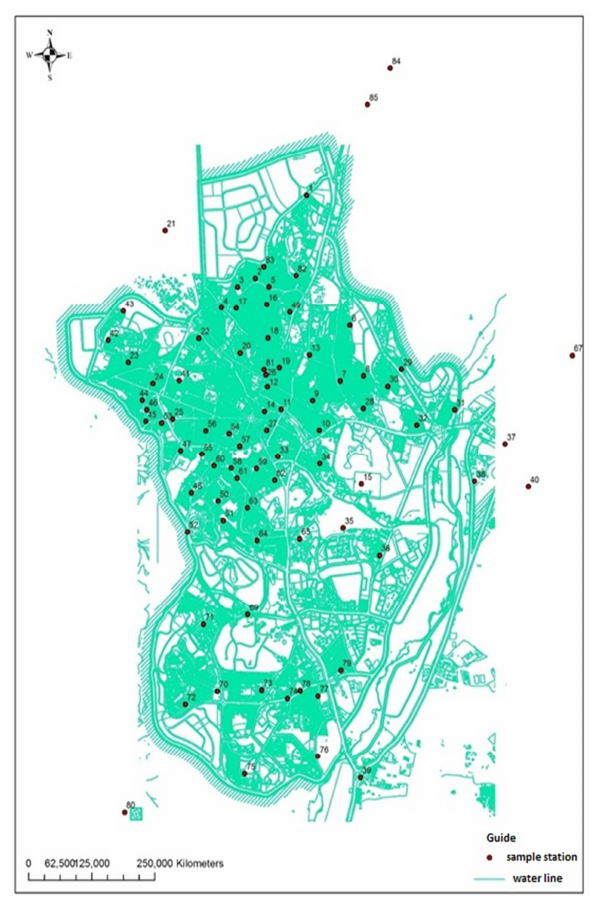
Figure 1. The location of sampling stations